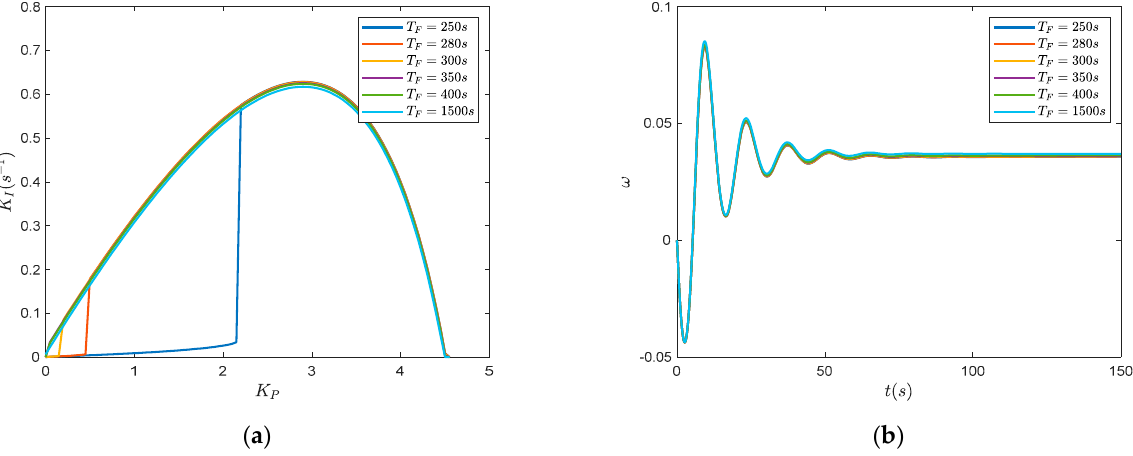
Figure 14. Effect of T F on stability and dynamic characteristics: ( a ) Stable region; ( b ) Dynamic response.